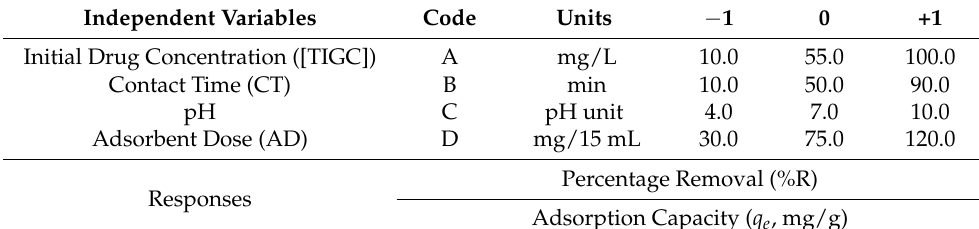
Table 1. Investigated variables at their three levels and the measured